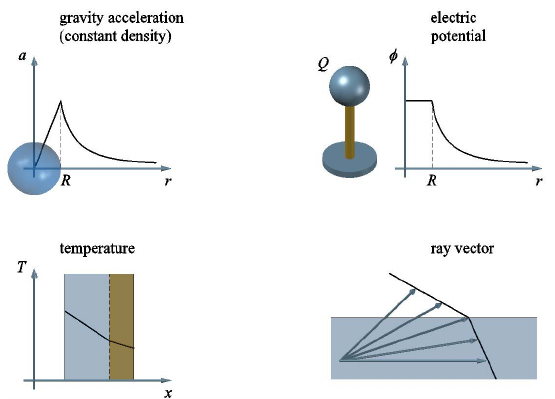
Figure 5: Continuity of the global variables associated with points in domains made of more than one